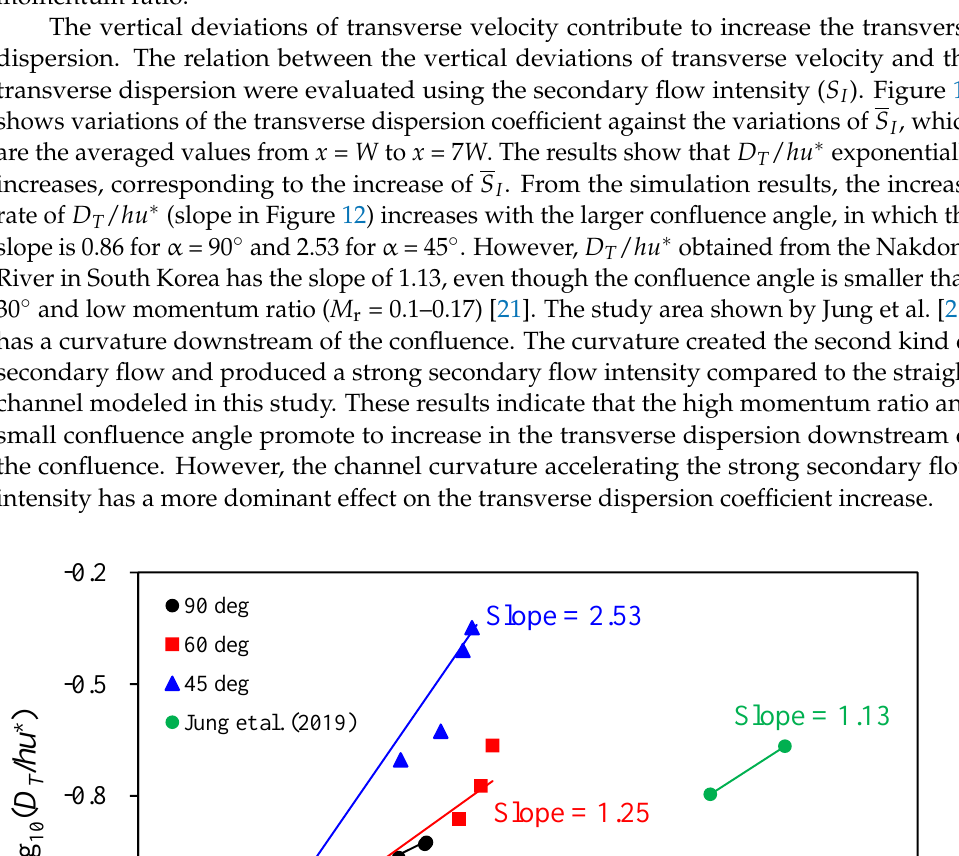
Table 4. Effects of the confluence angle and momentum ratio to flow and mixing properties in con- fluence.